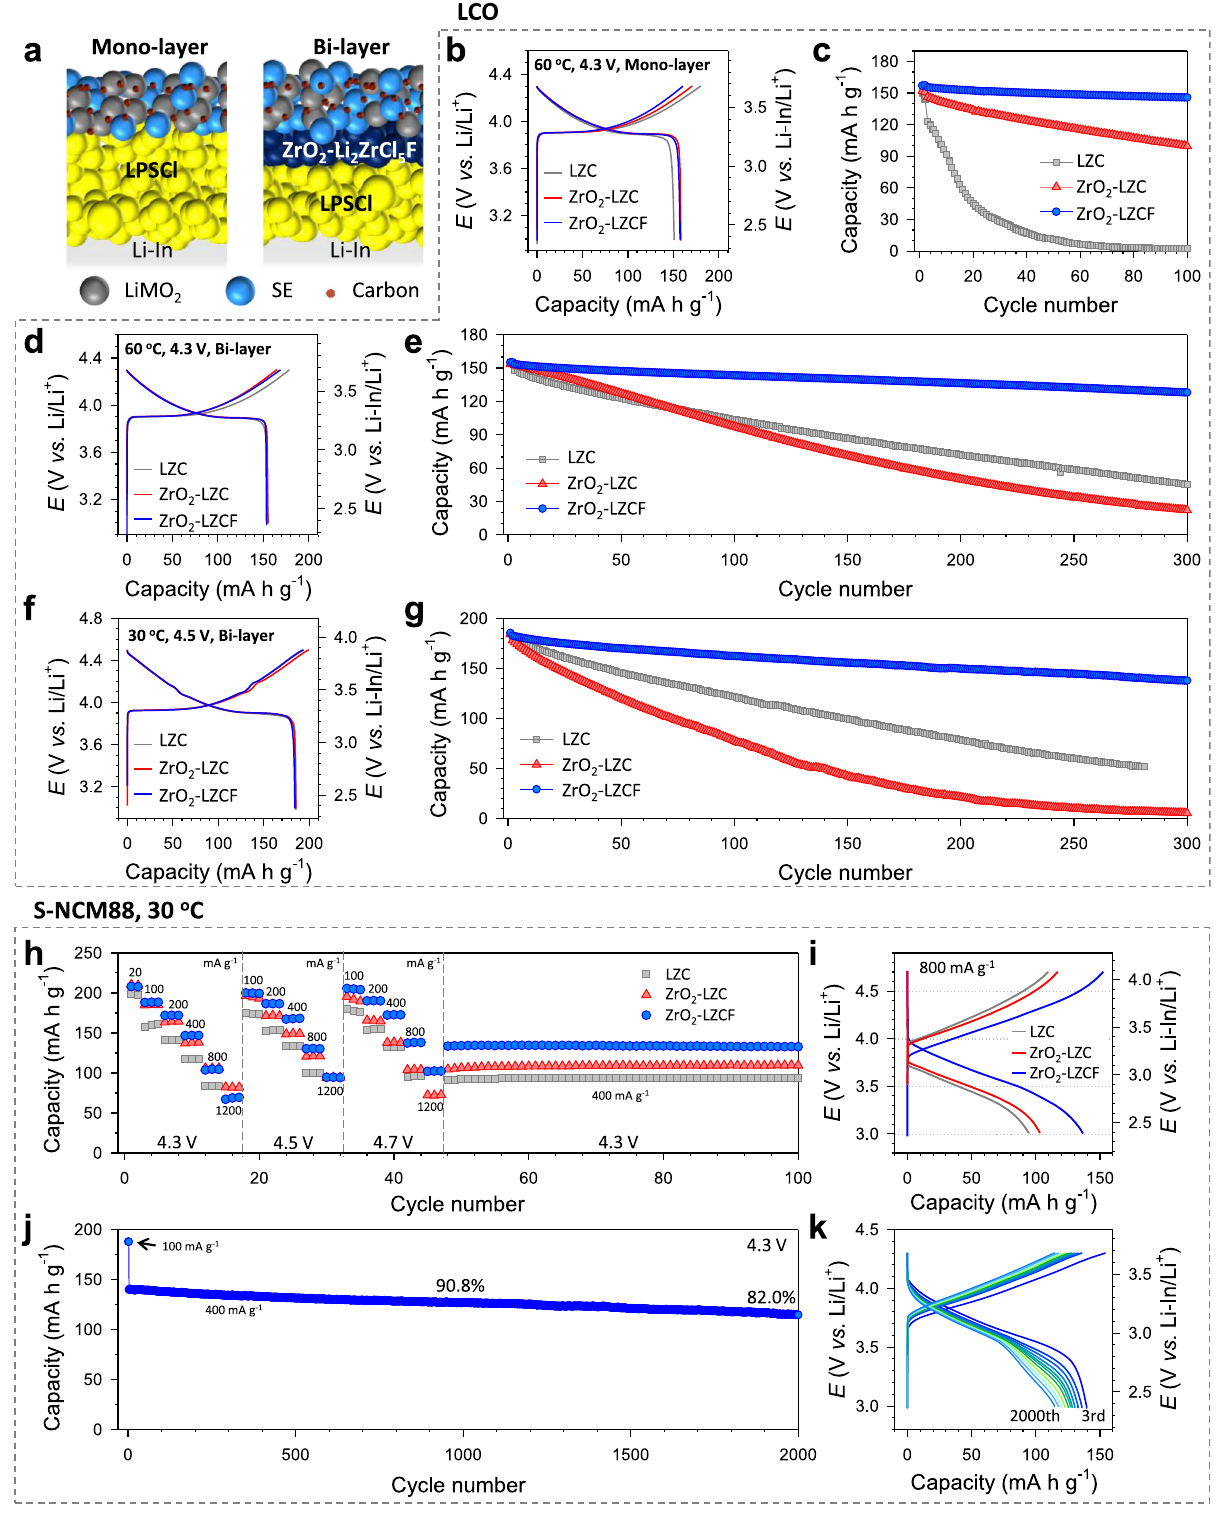
Fig. 5 | LCO and S-NCM88 ASSB cells employing HNSEs (ZrO 2 -2Li 2 ZrCl 6 and ZrO 2 -2Li 2 ZrCl 5 F vs. Li 2 ZrCl 6 ). a Schematics of ASSB cells employing an LPSCl monolayer or (ZrO 2 -LZCF)|LPSCl bilayer. b , c First-cycle charge – discharge voltage pro fi les at 16.4mAg − 1 and 60°C ( b )and cycling performances at 82.0mAg − 1 ( c )for LCO electrodes with an LPSCl monolayer cycled up to 4.3V (vs. Li/Li + ). d – g First- cycle charge – discharge voltage pro fi les at 16.4mAg − 1 and cycling performances at 82.0mAg − 1 for LCO electrodes with a ZrO 2 -LZCF bilayer cycled up to 4.3V at 60°C ( d , e ) and 4.5V (vs. Li/Li + ) at 30°C ( f , g ). h , i Rate capabilities with varying cut-off voltages( h )andthecorrespondingcharge – dischargevoltagepro fi lesat800mAg − 1